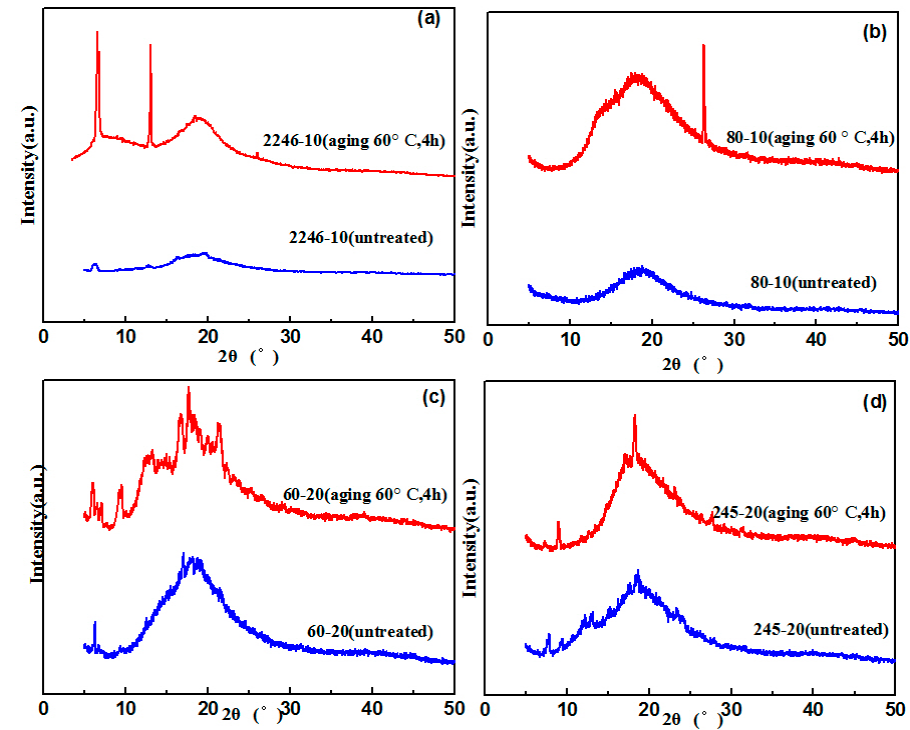
Figure 6. XRD patterns of XNBR/hybrid phenol blends ( a ) XRD patterns of XNBR/AO-2246; ( b ) XRD patterns of XNBR/AO-80; ( c ) XRD patterns of XNBR/AO-60; ( d ) XRD patterns of XNBR/XH-245.